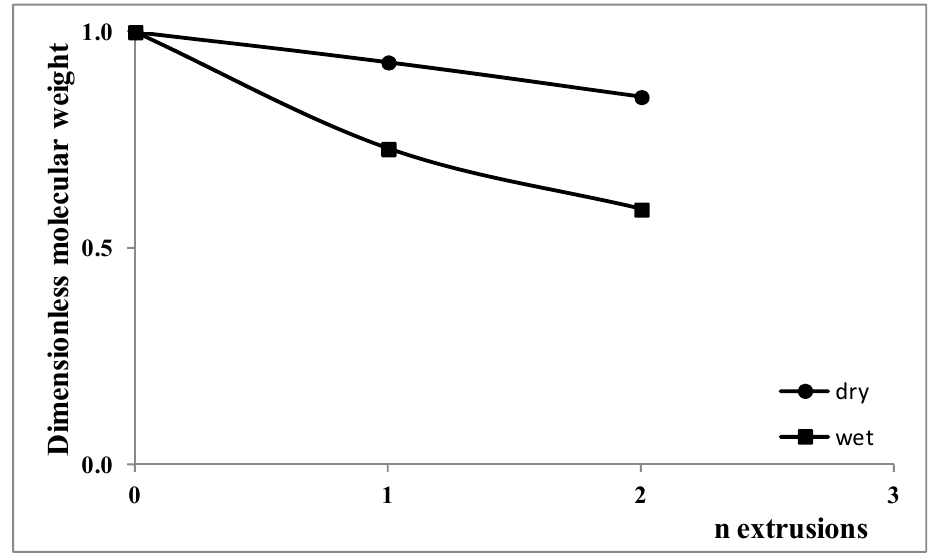
Figure 8. Dimensionless molecular weight.